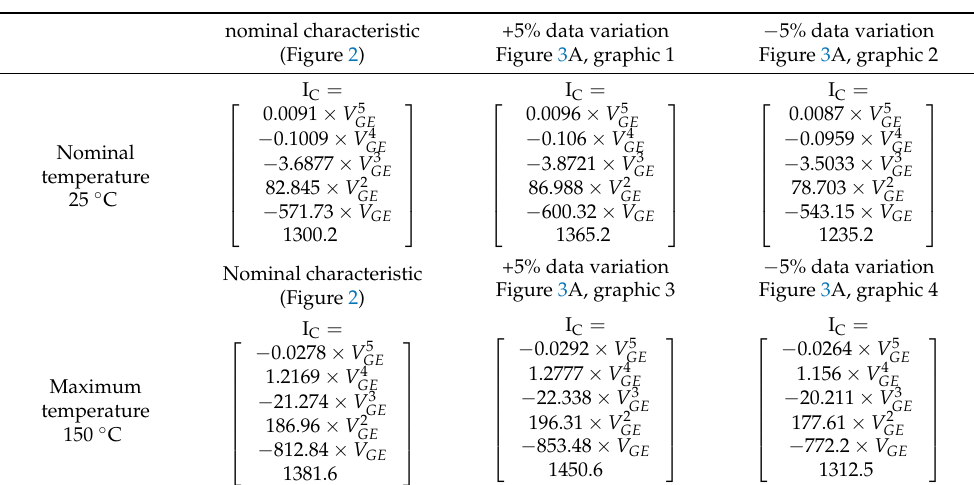
Table 1. Digitalisation of the transconductance characteristics, shown in Figure